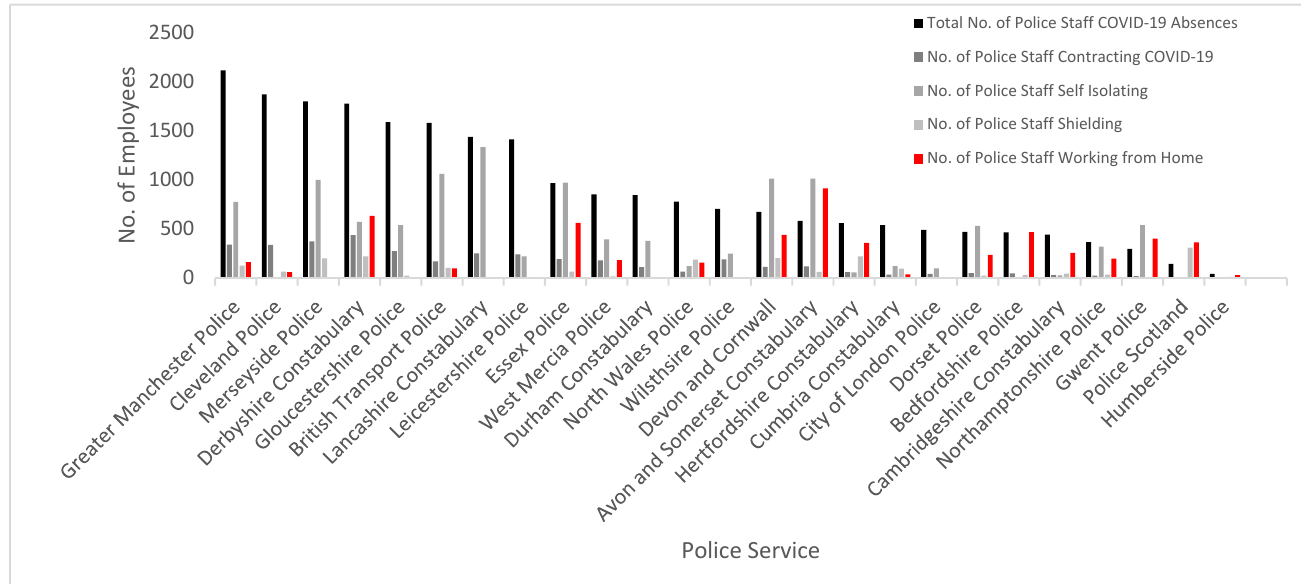
Figure 3. Overall impact of COVID-19 on police staff by police service.